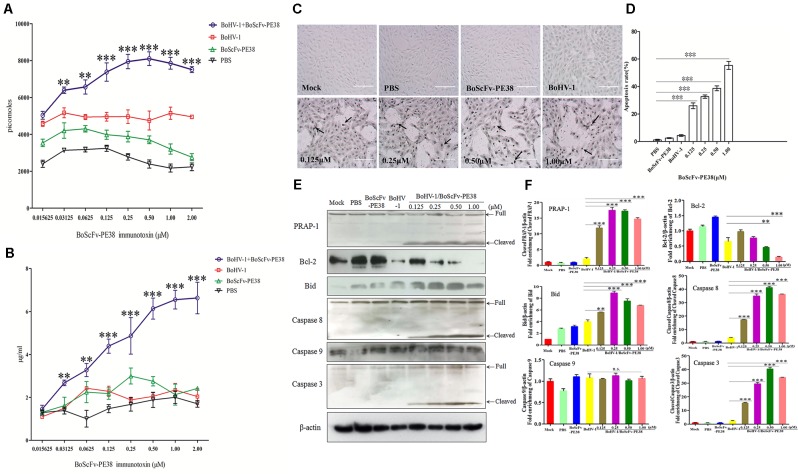
Apoptosis of BoHV-1-infected MDBK cells was induced by BoScFv-PE38. (A) The titration of ATP in BoHV-1-infected MDBK cells treated with BoScFv-PE38. MDBK cells were seeded in 96-well plates and cultured to 90% confluency at 37°C for 18–24 h. Then, the MDBK cells were infected with BoHV-1 (MOI = 1), added to the culture medium, and cultivated 37°C for 1.5 h. The culture medium was subsequently replaced with new culture medium containing 1% FBS and BoScFv-PE38 (0.015625, 0.03125, 0.0625, 0.125, 0.25, 0.50, 1.00, and 2.00 μM), and the MDBK cells were cultured for 24 h. The concentration of ATP was measured with a kit according to the manufacturer’s instructions. (B) The titration of ammonia in BoHV-1-infected MDBK cells treated with BoScFv-PE38. MDBK cells were treated as described above, and the concentration of ammonia was measured with a kit. Statistical analyses were performed via analysis of variance (ANOVA) using SPSS software, version 18.0, and the fitting curves of various concentrations of BoScFv-PE38 were drawn with GraphPad Prism 5.0. “∗∗” represents statistically significant differences (P < 0.01). “∗∗∗” represents statistically significant differences (P < 0.001). (C) The TUNEL assay. MDBK cells were seeded in 24-well plates and cultured to 90% confluency at 37°C for 18–24 h. Then, the MDBK cells were infected with BoHV-1 (MOI = 1), added to the culture medium, and cultivated at 37°C for 1.5 h. The culture medium was subsequently replaced with new culture medium containing 1% FBS and BoScFv-PE38 (0.125, 0.25, 0.5, and 1 μM), and the MDBK cells were cultured for 24 h. The apoptosis-positive MDBK cells were detected with the In Situ Cell Death Detection Kit, AP (Roche) according to the manufacturer’s instructions. The arrows indicate the TUNEL-positive apoptotic cells. (D) Apoptotic rates of BoHV-1-infected MDBK cells in the presence of different concentrations of BoScFv-PE38. The TUNEL-positive MDBK cells were counted, and statistical analyses were performed via analysis of variance (ANOVA) using SPSS software, version 18.0. The fitting curves of various concentrations of BoScFv-PE38 were drawn with GraphPad Prism 5.0. “∗∗∗” represents statistically significant differences (P < 0.001). (E) Expression of apoptosis proteins in BoHV-1-infected MDBK cells after treatment with BoScFv-PE38. MDBK cells were seeded in six-well plates and cultured to 90% confluency at 37°C over 18–24 h. Then, the MDBK cells were infected with BoHV-1 (MOI = 1), added to the culture medium, and cultivated at 37°C for 1.5 h. The culture medium was subsequently replaced with new medium containing 1% FBS and BoScFv-PE38 (0.125, 0.25, 0.5, and 1 μM), and the MDBK cells were cultured for an additional 24 h. The whole-cell proteins were separated via SDS-PAGE and transferred to PVDF membranes. The membranes were subsequently hybridized with antibodies against PARP-1, Bcl-2, Bid, caspase-8, caspase-8 and β-actin, and the blots were developed using Super Signal chemoluminescent substrates. (F) Apoptosis proteins quantification of band intensity by Image J software, representative results are displayed with graphs corresponding to the ratios of cleaved PRAP-1, Bcl-2, Bid, caspase 8, caspase 9 and caspase 3 normalized to theβ-actin control conditions. The data were analyzed using SPSS software, and the graph was produced using GraphPad Prism 5.0. “n.s.” represents no statistically significant differences (P > 0.05). “∗∗” represents statistically significant differences (P < 0.01). “∗∗∗” represents statistically significant differences (P < 0.001).